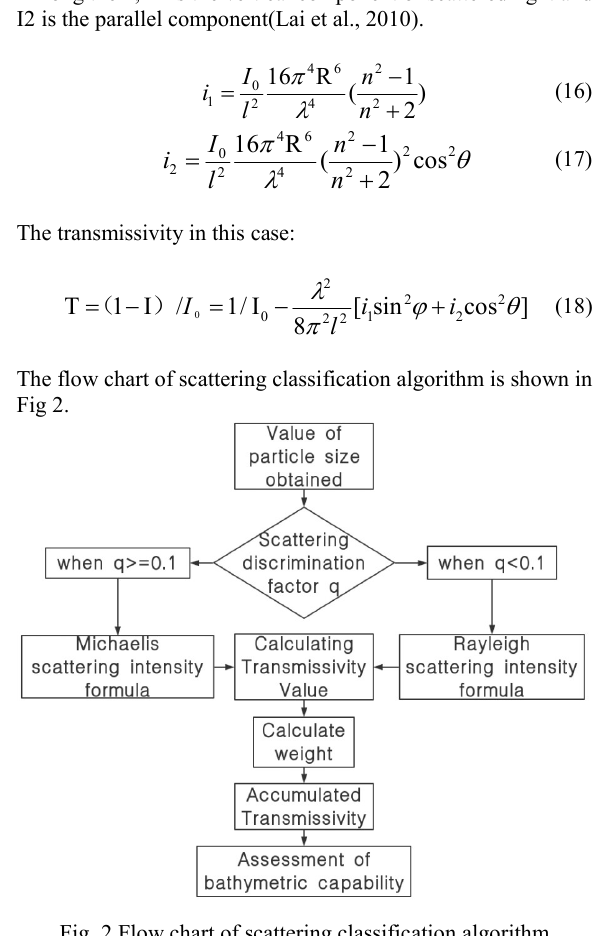
Fig. 2 Flow chart of scattering classification algorithm Random numbers are generated to simulate the particle sizes of different particle and distributions in seawater. In the scattering classification algorithm, the scattering of light by each